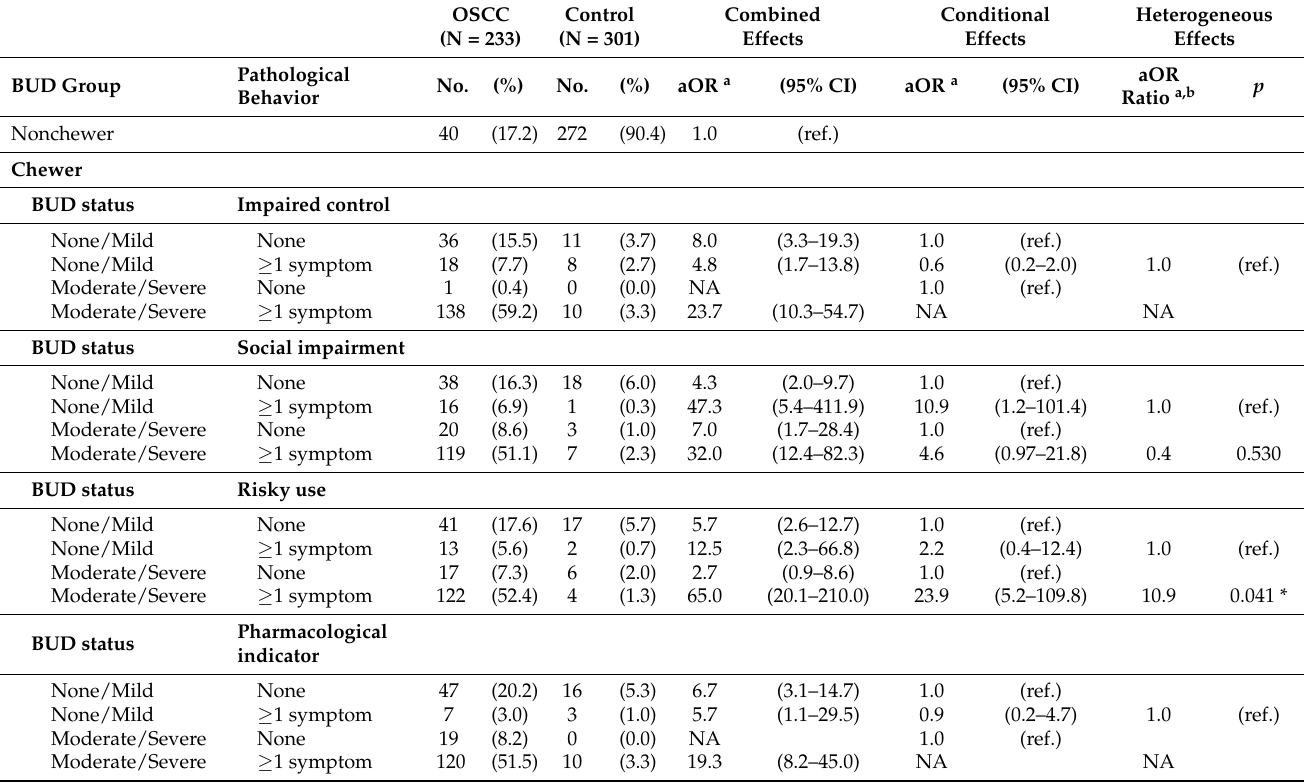
Table 6. Combined, conditional, and heterogeneous effect of DSM - 5 betel quid use disorder and pathological behavior on oral squamous cell